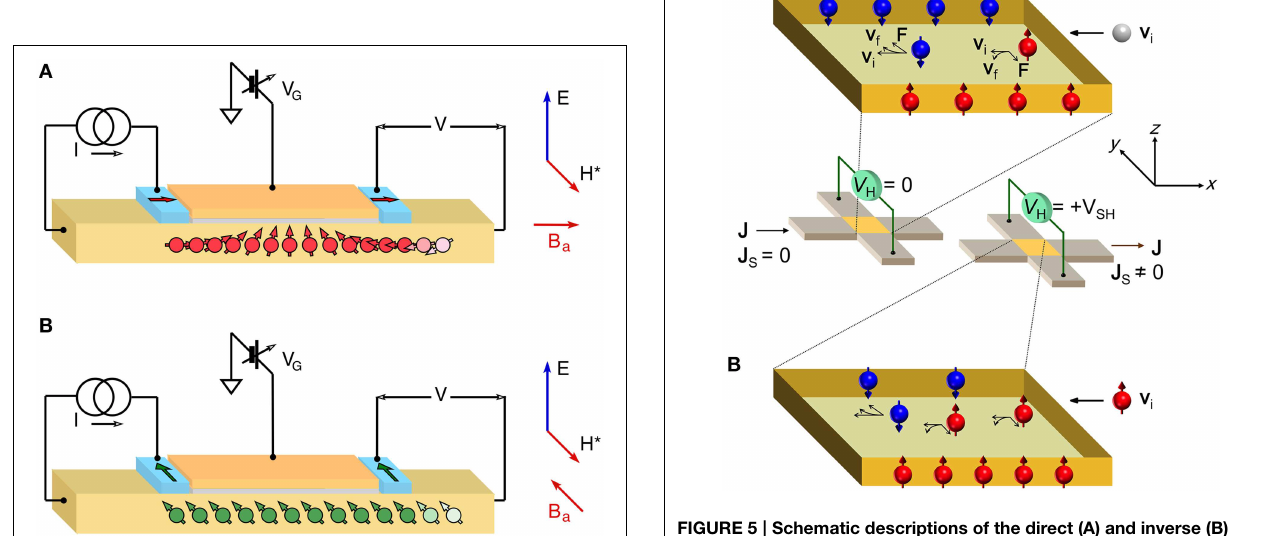
FIGURE 5 | Schematic descriptions of the direct (A) and inverse (B) spin Hall effects. “ (A) DSHE. Unpolarized current E J flows, with initial electron velocity v i along x , in a material with strong spin-orbit interaction. Spin Hall FIGURE 4 | Schematic representation of the Datta-Das experiment, −ˆ force E F has opposite sign on electrons with opposite spin. Down-spin adapted to the NLSV geometry. The distance L between ferromagnetic (up-spin) electrons [blue (red) spheres] are pushed along the positive (negative) injector and detector is fixed and is less than a ballistic mean free path. The y direction, creating equal populations of spin-polarized electrons on opposite channel between source and drain can be gated. (A) The injected electrons sides of the sample. Inset: A Hall voltage measurement shows V H have spin orientation along 0 . (B) y and the orientation is not affected by gate voltage ˆ = ISHE. When E J has more up-spins than down-spins, it’s a spin polarized V G . (B) The electrons are injected with spin orientation along x and precess ˆ current, E J S . In response to E F , there are unequal populations on opposite sides. under a torque from B R ( y ) . As V G is varied, the wavelength λ changes and −ˆ A Hall measurement gives the spin Hall voltage, V H V SH , proportional to the the detector records a conductance oscillation 1 R ( V G ) . Reproduced from Koo = population difference.” Figure and caption are reproduced from Choi et al. et al. [22].